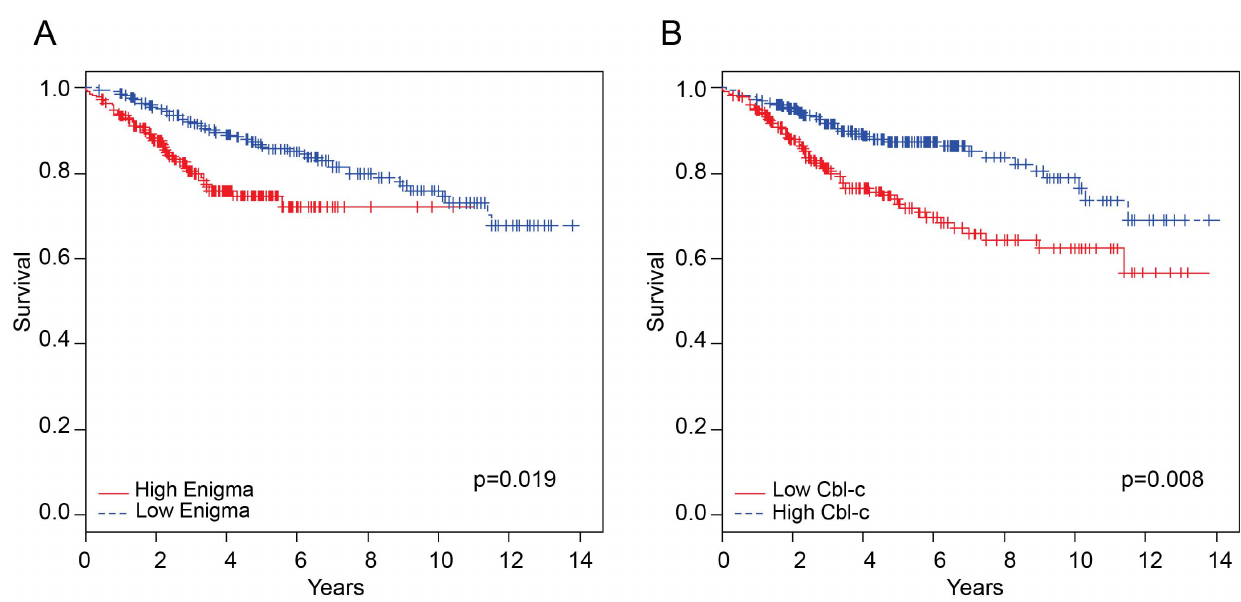
Figure 5. Comparison of survival outcome between Enigma and Cbl-c expression in high RET expressing breast cancers. Kaplan- Meier survival analysis over time with high vs. low Enigma expression ( A ) and high vs. low Cbl-c expression ( B ). The P-value was determined by log- rank test between risk groups.